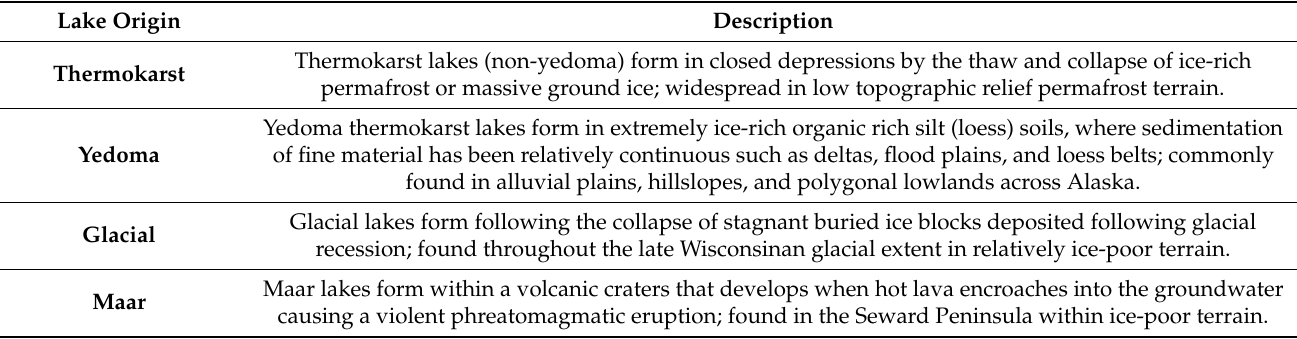
Table 1. Description of the four principal lake origins, found across the permafrost region in northern Alaska.